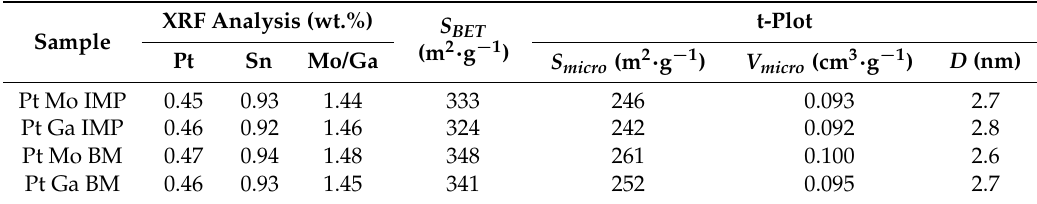
Table 1. Textural properties and chemical composition of Pt Mo ball-milling (BM), Pt Mo impregnation (IMP), Pt Ga BM, and Pt Ga IMP samples.